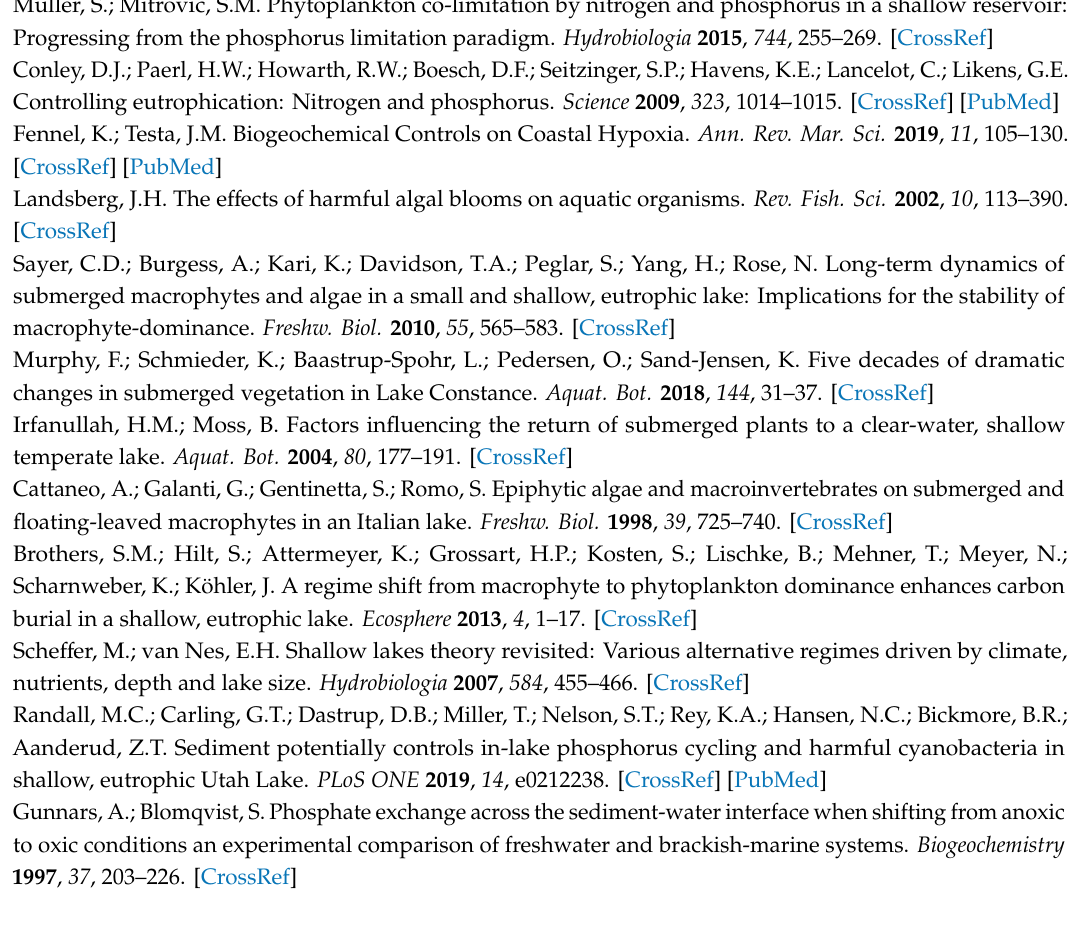
Table S1. Introduction of the analysis of covariance (ANCOVA) during the statistical analysis. Table S2. Sediment properties and variations during the field investigation. Table S3. Pearson’s correlation matrix of various